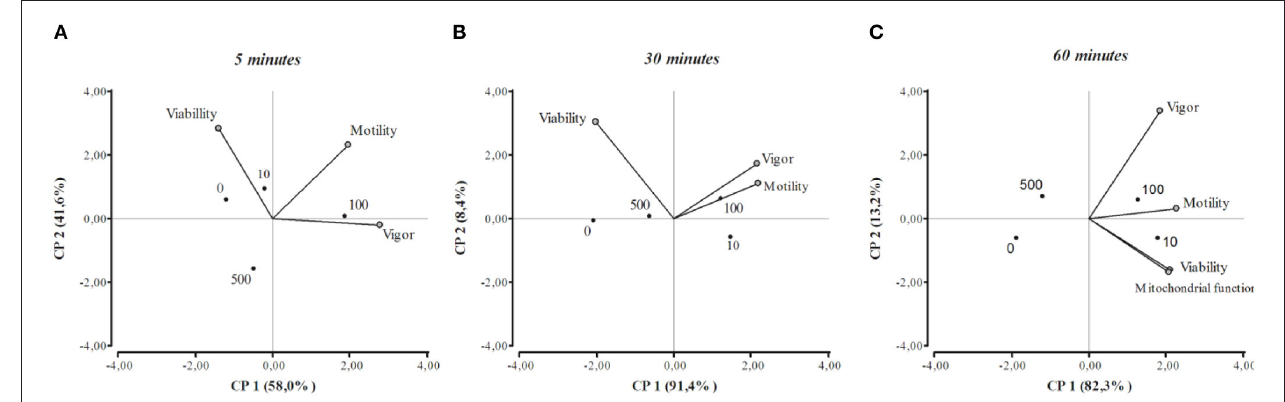
FIGURE 4 | Principal component analysis biplot at 5, 30, and 60min of incubation with β -NGF (A–C) , showing the first two principal components (PC1 and PC2). Vectors indicate the relations between viability, motility, sperm vigor, and mitochondrial function. Each vector points in the direction of the increase in value. The dots represent the mean value for each concentration of β -NGF (0, 10, 100,